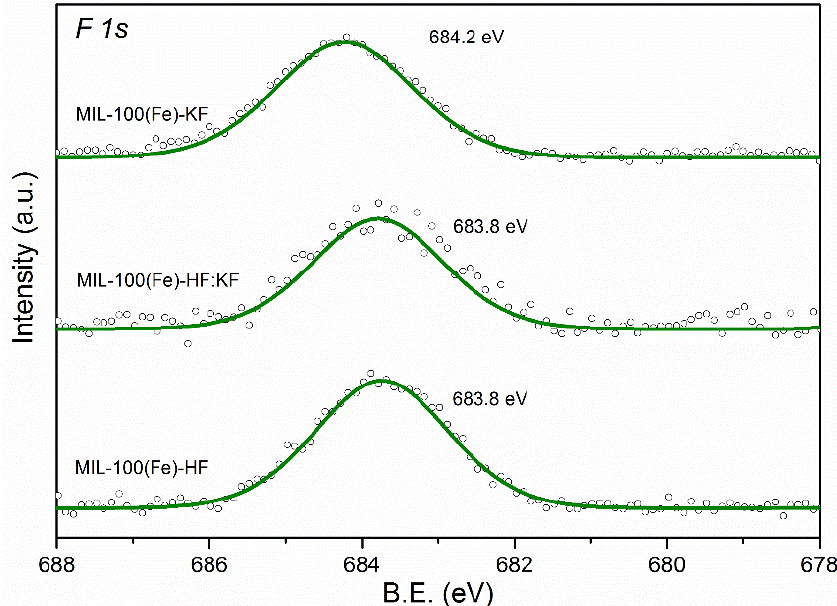
Figure 7. XPS spectra of the synthesized samples. The figure shows the F 1s core-level spectra. Taken altogether, it can be concluded that, under the synthesis conditions used, two phases were generated: MIL-100(Fe) and the so-called Fe(BTC). The ratio of the two phases differed depending on the fluorine source used. Furthermore, we can see that, when no fluorine was used and the fluorine source was not HF, the samples had a higher proportion of Fe(BTC) and a higher amount of uncoordinated carboxylic groups, thus causing a large number of